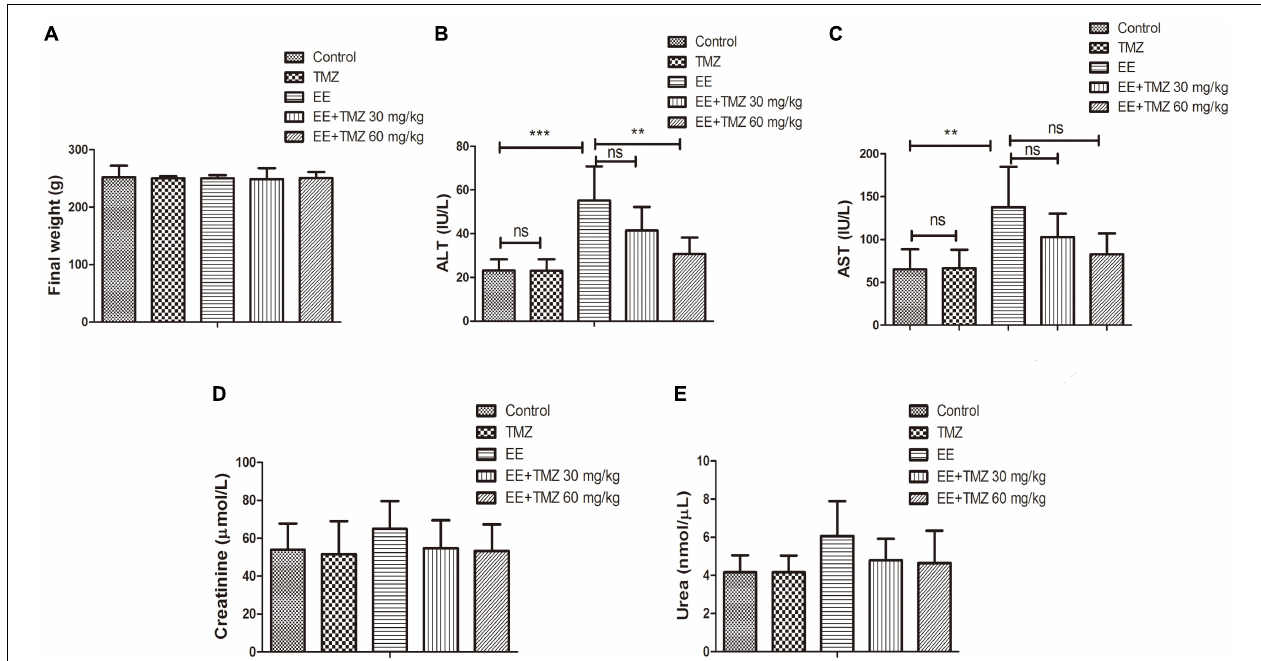
FIGURE 1 | Trimetazidine (TMZ) repressed exhaustive exercise (EE)-induced changes in liver function in rats. The final body weight (A) , serum alanine aminotransferase (ALT) (B) , aspartate aminotransferase (AST) (C) , creatinine (D) , urea (E) levels are shown. Each value is shown as mean ± SD ( n = 6). ∗∗ P < 0.01, ∗∗∗ P < 0.001, versus the indicated